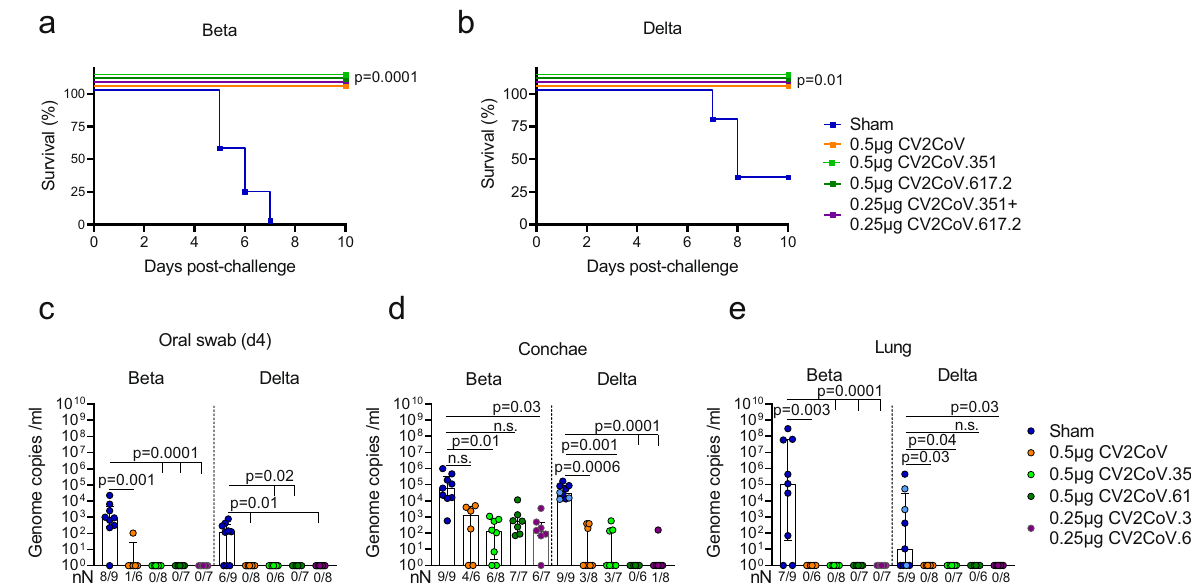
Fig. 1 | Monovalent and bivalent mRNA vaccines encoding ancestral, Beta and Delta derived S-protein sequences protect against SARS-CoV-2 variants in a transgenic mouse model. Female K18-hACE2 mice vaccinated on days 0 and 28 with a total of 0.5 µ g CV2CoV (ancestral, orange), 0.5 µ g CV2CoV.351 (Beta, light green), 0.5 µ g CV2CoV.617.2 (Delta, dark green), CV2CoV.351+CV2CoV.617.2 (0.25 µ gofeach;purple)orNaCl(sham;blue)werechallengedi.n.with10 4.4 TCID 50 SARS-CoV-2 variant B.1.351 (Beta) or B.1.617.2 (Delta) at day 56. Animal numbers analysed are summarized in Table S1. a , b Survival curves (Kaplan – Meier) for K18- hACE2micechallengedwithB.1.351(Beta)( a )orB.1.617.2(Delta)( b )withfollow-up